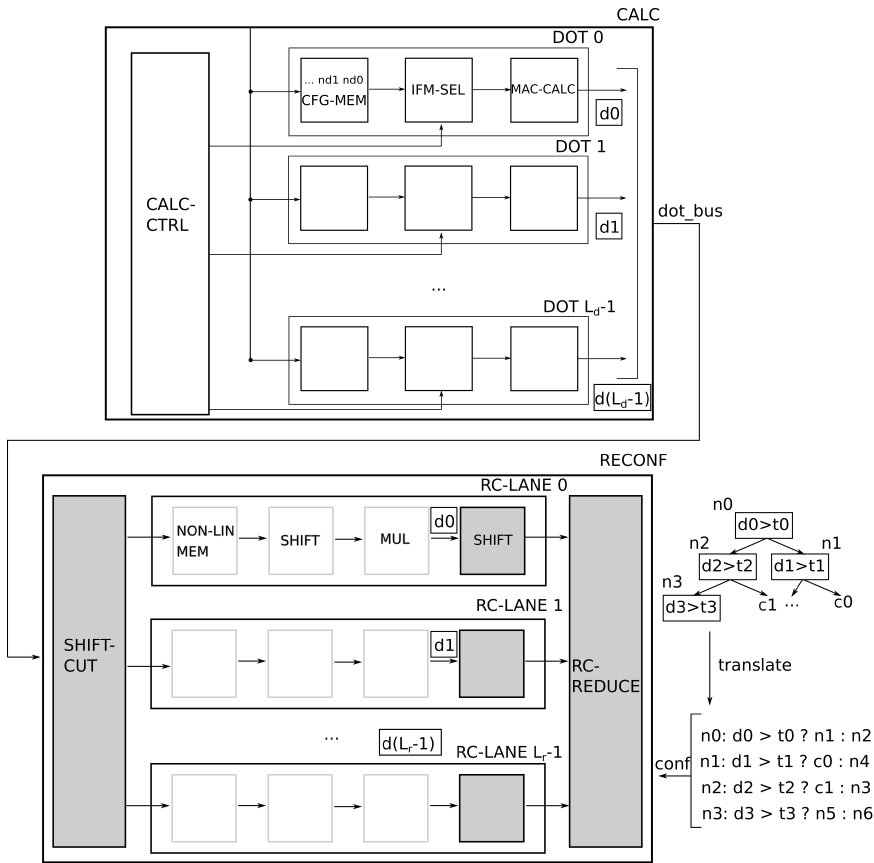
Figure 8. The RECONF architecture—DT